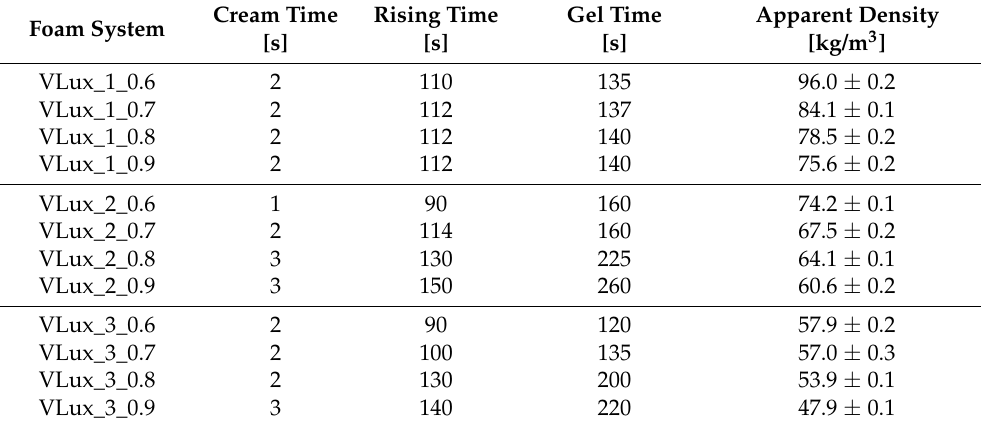
Table 3. Characteristic time, the apparent density of manufactured